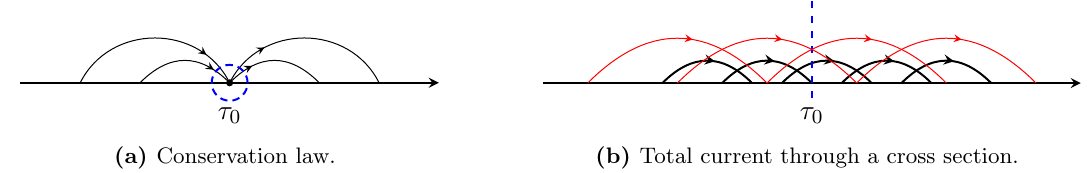
Figure 1. (a) Conservation law: the total current through a closed (dashed) circle is zero; (b) Flow Q , as the total current through a cross section (cid:28) 0 (blue dashed line), is independent of the position (cid:28) 0 . In general, there are contributions from all time scales; longer scale currents are shown in